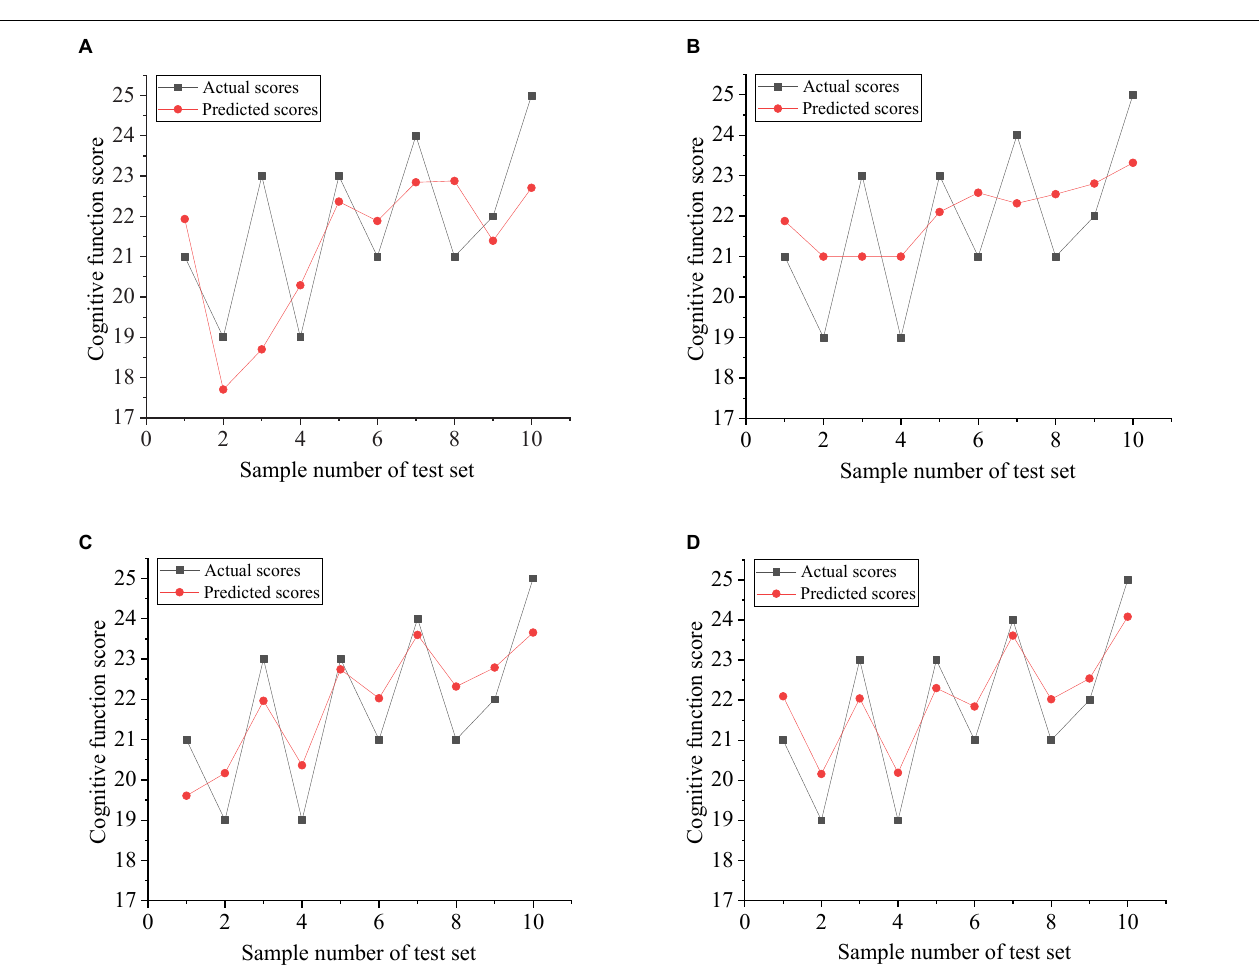
FIGURE 4 | Actual scores and predicted scores of various models. (A) GTA-SVRM. (B) GTA-LSSVRM. (C) GTA-WOA-SVRM. (D) GTA-WOA-LSSVRM.